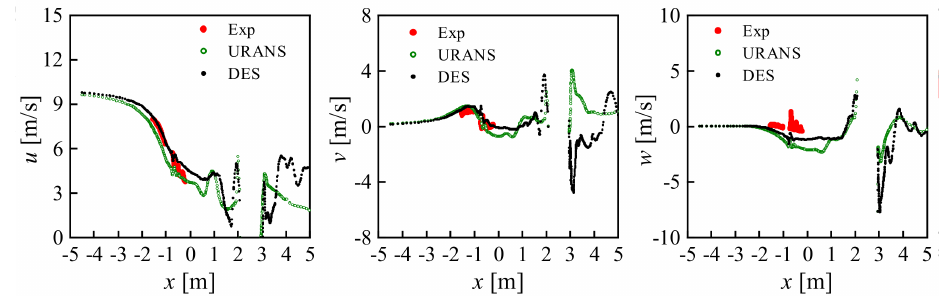
Figure 20. Axial profile of velocity components at y = 1.5 m under wind speed of 10 m/s, TSR = 10.